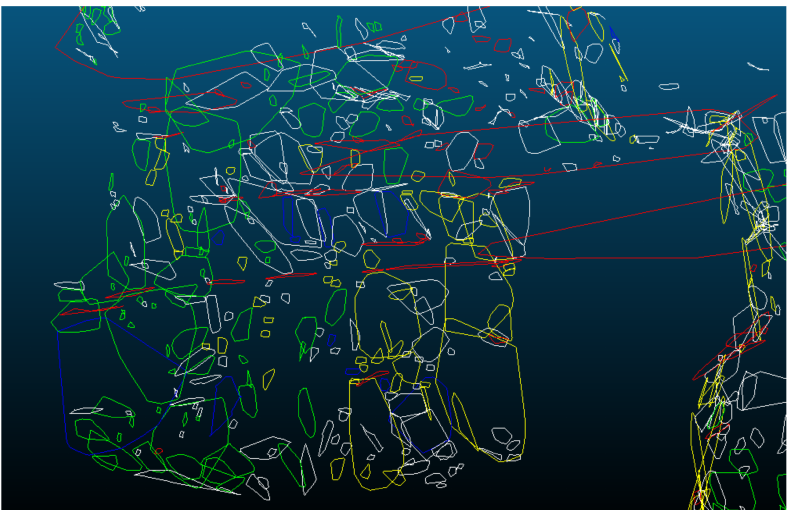
Figure 11. 3D representation of the discontinuity plans remotely extracted and divided by family. White: no family; red: BG; yellow: JN1; green: JN2; blue: